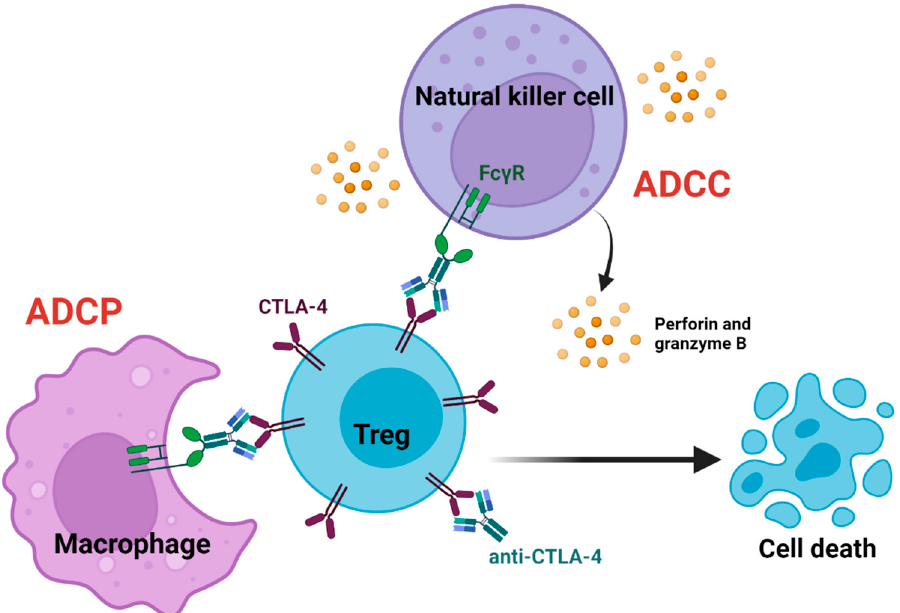
Figure 2. Antibody-mediated Treg depletion. Anti-CTLA-4 bound to Tregs can engage with Fc γ Rs expressed on innate cells to deplete Tregs. Macrophages and natural killer cells can deplete Tregs through antibody-dependent cellular phagocytosis (ADCP) and antibody-dependent cellular cytotoxicity (ADCC). Depleting intra-tumoral Tregs promotes anti-tumor immune responses by transforming the immunosuppressive nature of the tumor microenvironment into a pro-inflammatory microenvironment. This is enabled by indirectly increasing anti-tumor effector T-cells' activation, infiltration, and effector functions.